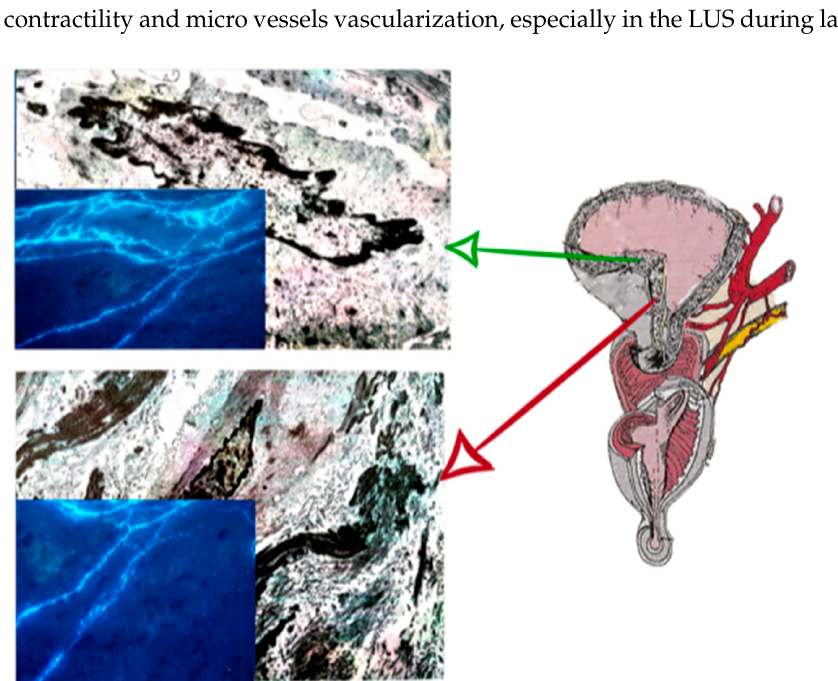
Figure 2. Proposed mechanism of adrenergic and noradrenergic fibers effects in dystocic prolonged labor.